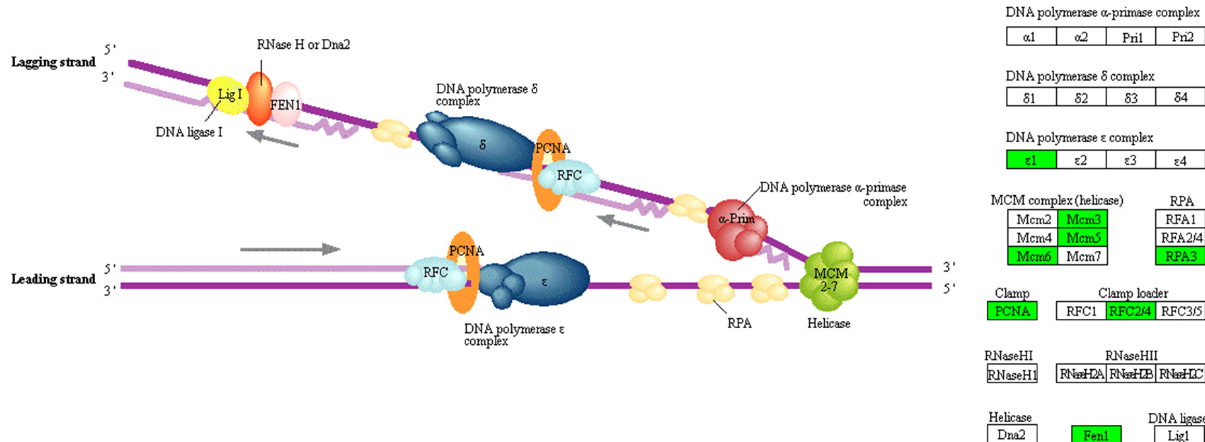
Figure 5. DNA replication of jejunum epithelial cell. This figure is based on the pathway bta03030 shown in KEGG [42]. Green markers indicate that proteins encoded by genes with reduced expression levels in treated calves. The graph was produced by “pathview” in